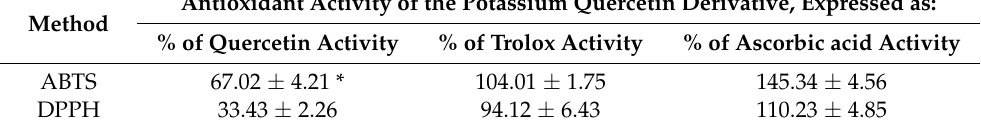
Table 1. Antioxidant activity against ABTS and DPPH of the potassium quercetin derivative, expressed as % of the standard substance activity. * Mean ± SD.